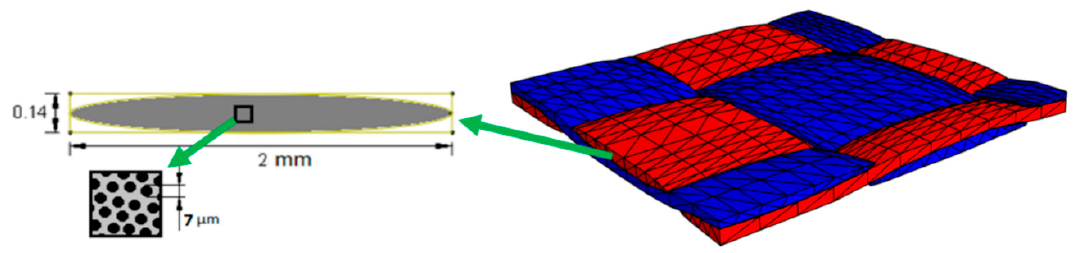
Figure 1. Tows geometry at the micro- and meso-scales.